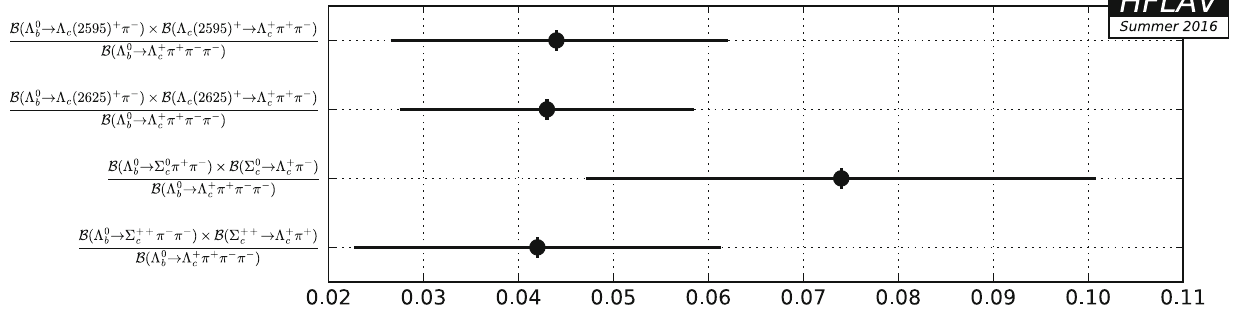
Fig. 175 Summary of the averages from Table